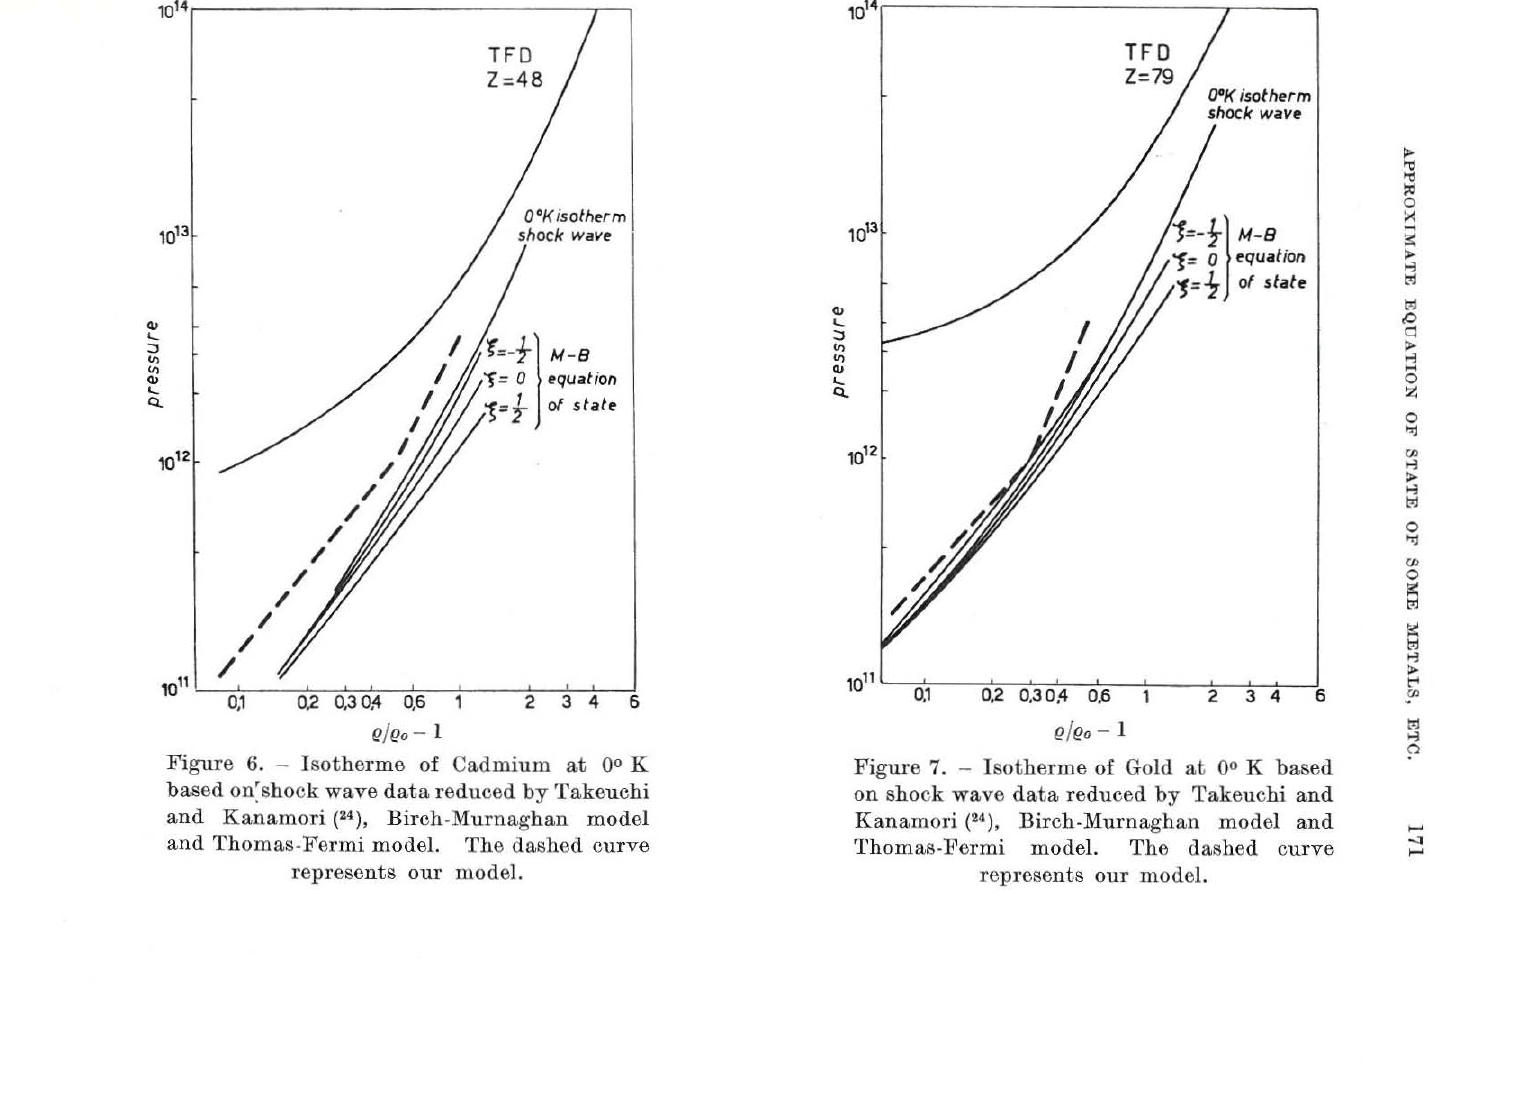
Figure 7. - Isotherme oI Gold at 0 0 K based on shock wave data reduced by Takeuchi and Kanamori (24), Birch-Murnaghan modei and Thomas-l!"1errni mode!. The dashed curve reprcsents OUI'